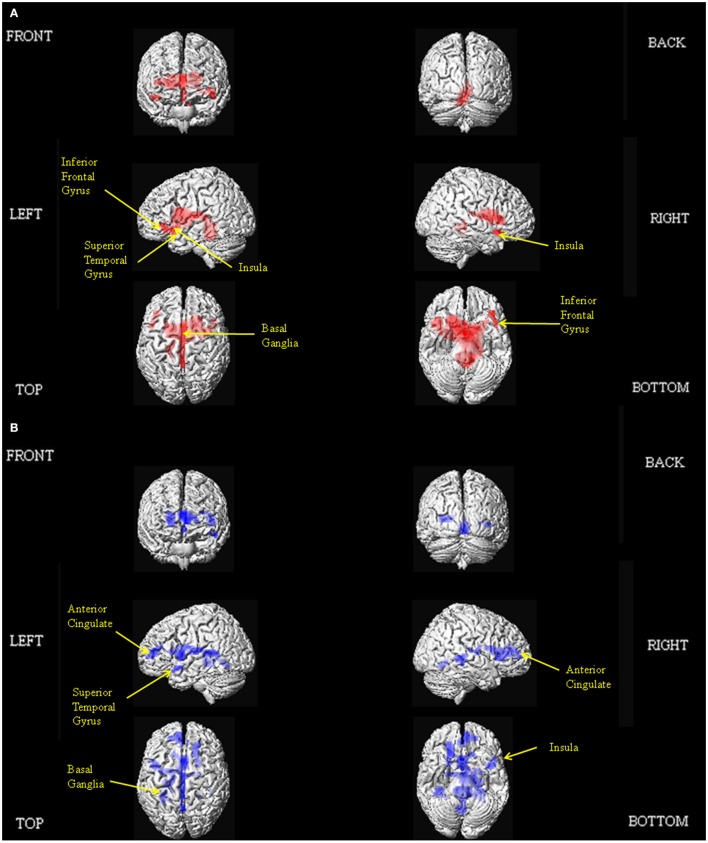
Depiction of the brain regions activated when expressing anger (A), and happiness (B) through prosody (relative to neutrality), displayed on a rendered brain derived from the Montreal Neurological Institute Ch2bet.nii image supplied with the MRIcroN software (http://www.mccauslandcenter.sc.edu/mricro/mricron/index.html). Regions of activation on the external surface of the cortex appear brighter and more intense, whereas regions deeper in the cortex are displayed in less intense, more transparent shades. Images are thresholded at PFWE <0.05 with a 10 voxel spatial contiguity threshold.